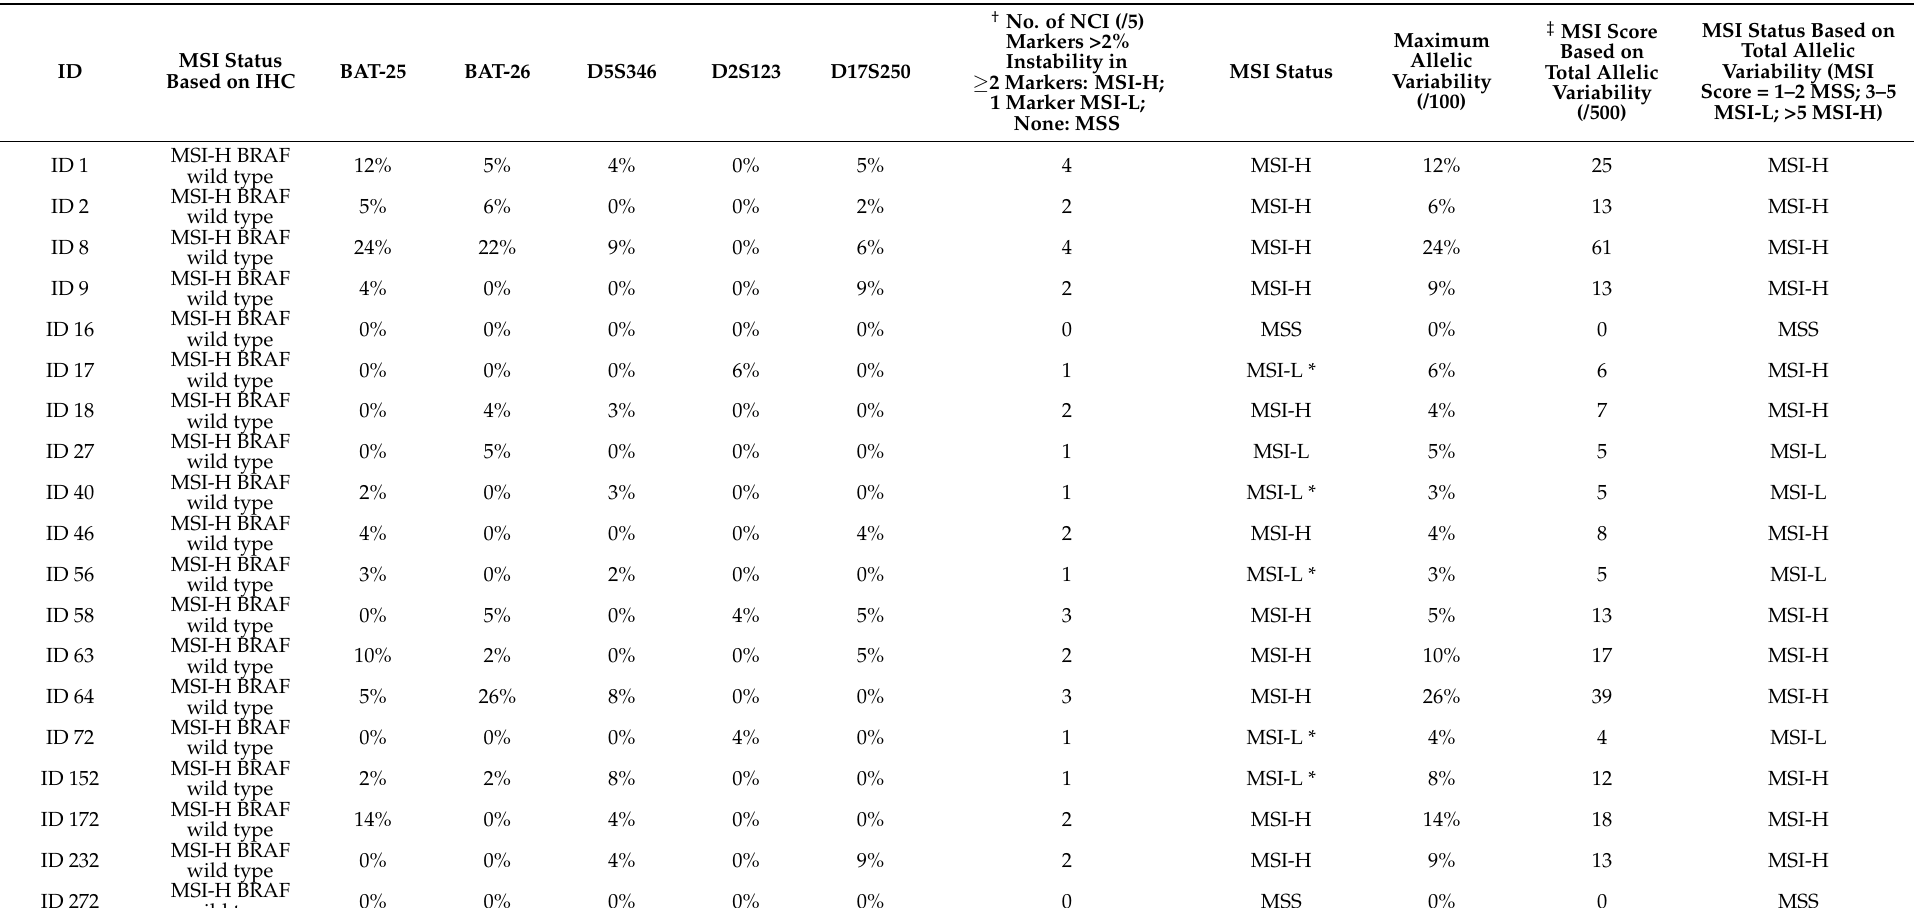
Table 6. Correlation between MSI status detection using high-resolution capillary electrophoresis with (a) traditional analysis and (b) MSI score based on total allelic variability, compared to immunohistochemistry (IHC) for MSI-H:BRAF wild type tumours from patient